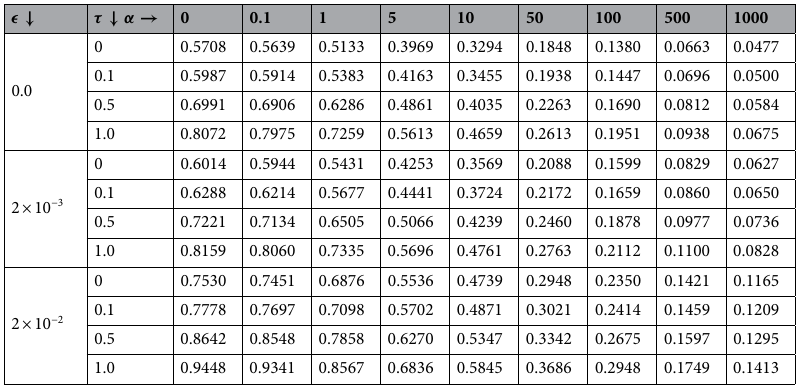
Table 3. Floating width r f (α , τ , ǫ) .